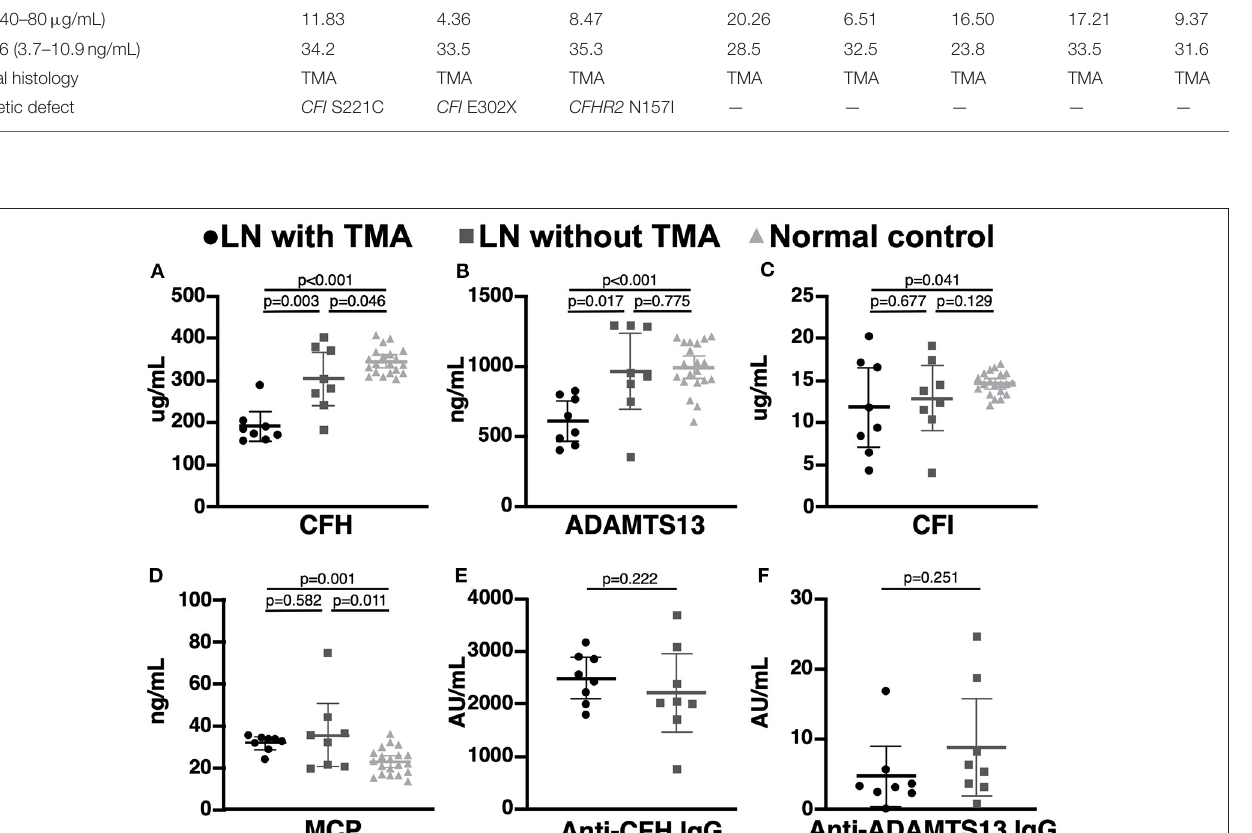
Frontiers in Medicine |